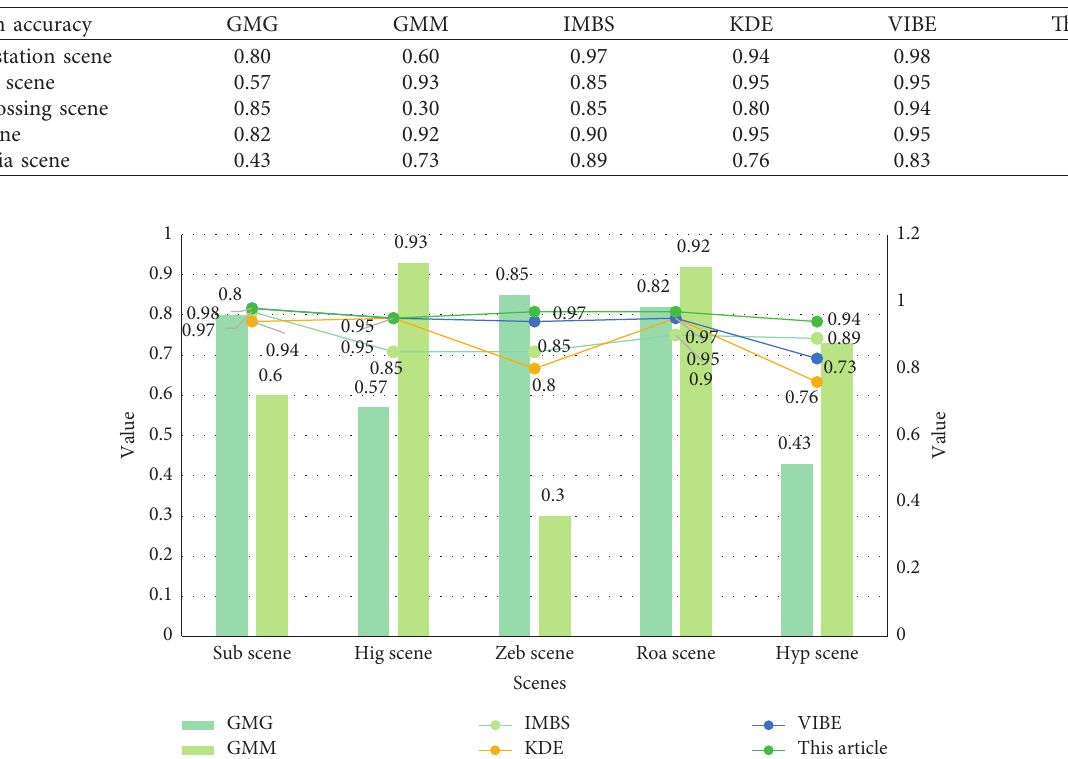
Figure 9: The accuracy index chart of camera shake video library scene